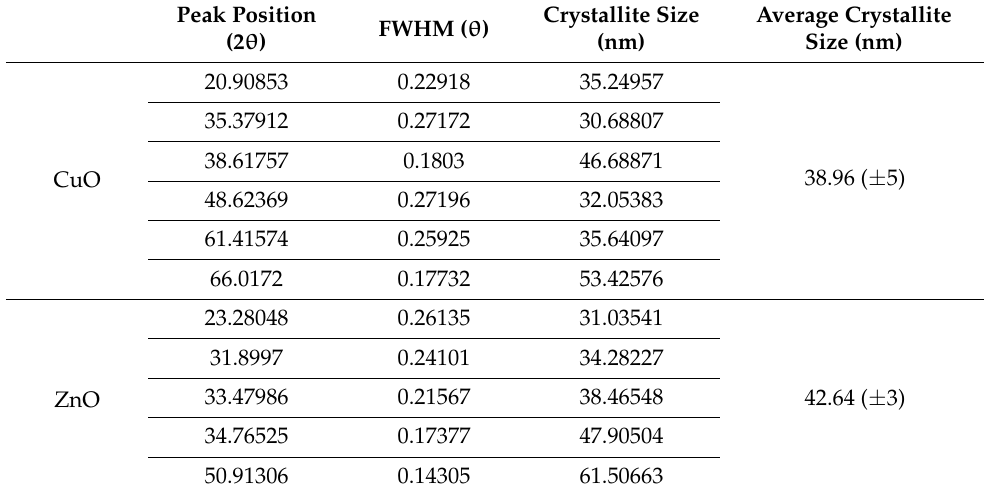
Table 1. Determination of the crystallite size of biosynthesized CuO and ZnO nanoparticle synthe- sized using XRD analysis.